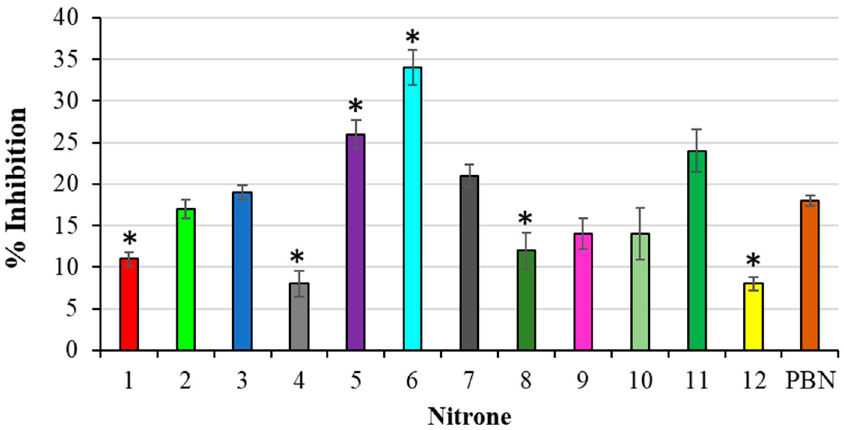
Figure 5. % Inhibition of TBARS formation during deoxyribose oxidation. Results are expressed as mean ± SD ( n = 5). Nitrones derivative versus PBN nitrone, * p < 0.05.